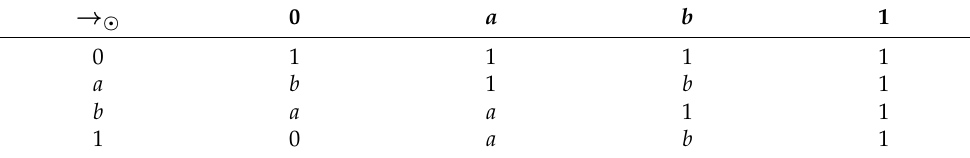
Table 2. The operation → (cid:12)